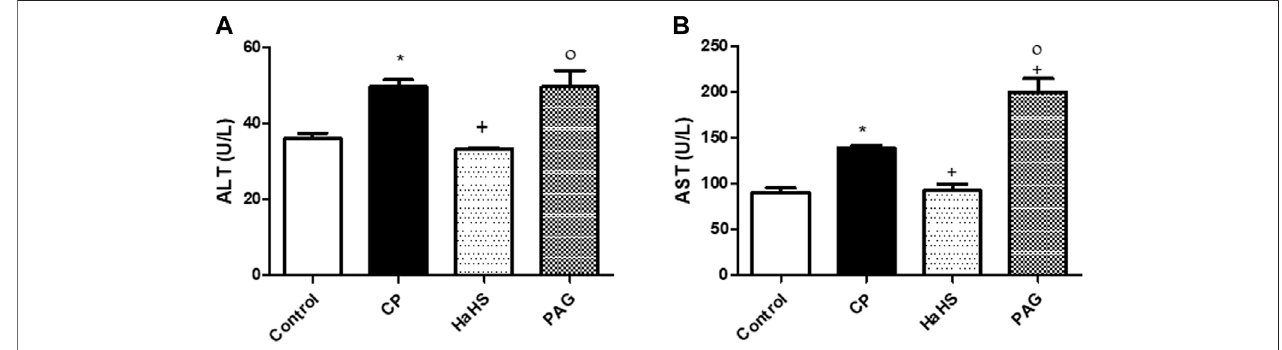
FIGURE 1 | Effect of NaHS and PAG on the serum levels of ALT (A) and AST (B) in CP-induced induced hepatotoxicity in rats. Data are represented as mean ± SEM.*,+, ° aresigni fi cantlydifferentfromcontrol,CPandNaHSgroups, respectively, wheren=6and p < 0.05.CP;cyclophosphamide,PAG; DL-propargylglycine,ALT; alanine aminotransferase, AST; aspartate aminotransferase.